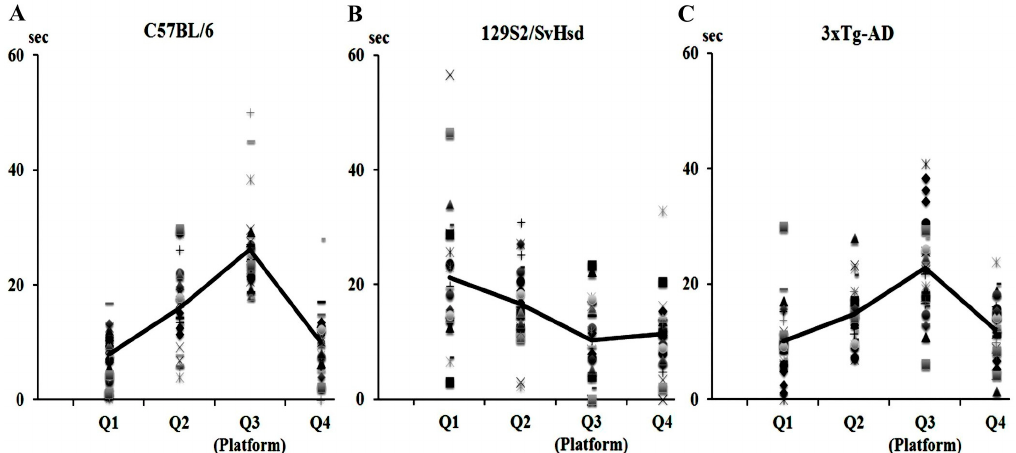
Figure 2. The total time (in seconds) spent in each quadrant (Q1, Q2, Q3, and Q4) during a 60-s probe trial (without the escape platform which was placed in Q3 during the 10-day training) is presented for the three strains of mice ( A – C ). Each individual animal’s time is plotted by different marks. Solid black lines show the mean time spent in each quadrant.